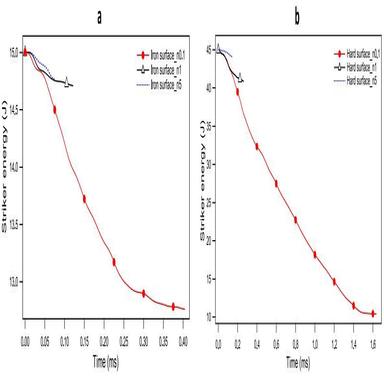
Impactor energy-time graphs for Charpy impact test of FGM samples impacted from a) iron, b) hard surfaces.